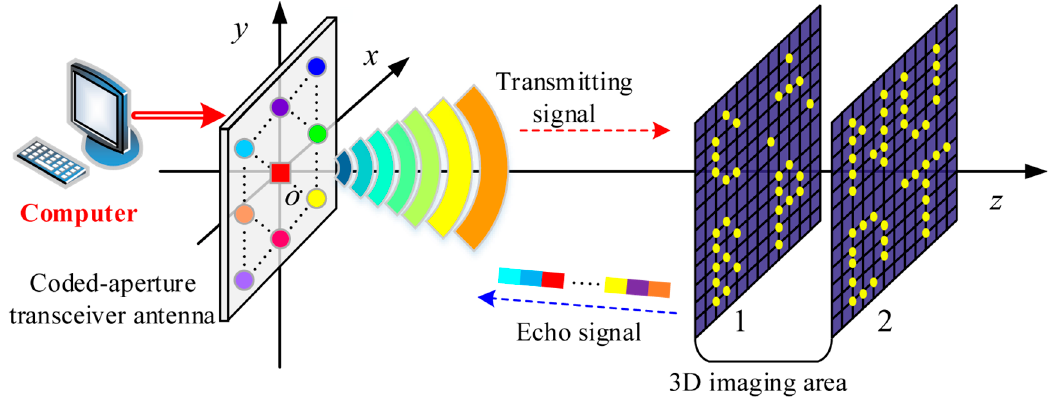
Figure 3. Schematic diagram of 3D back projection (BP) ‐ TCAI architecture.